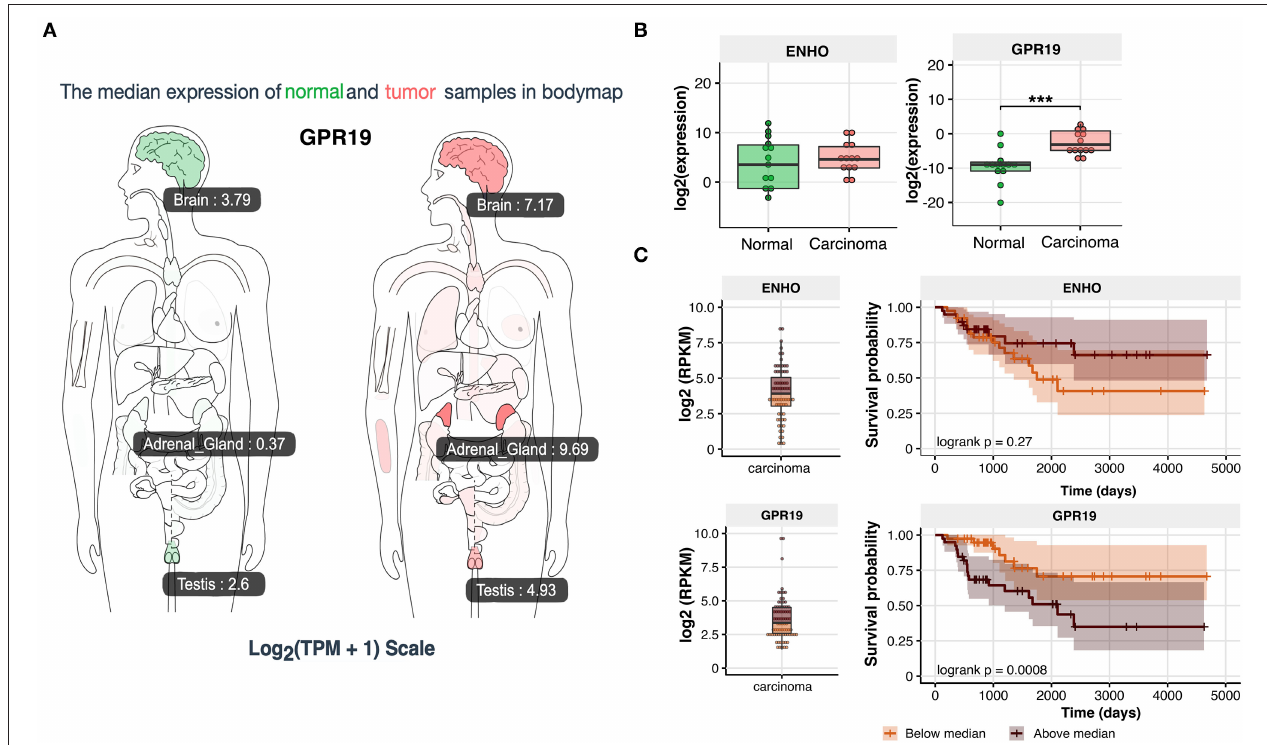
FIGURE 12 | Expression of ENHO and GPR19 in clinical samples. (A) Profile of GPR19 expression in normal and tumor samples from GEPIA (Gene Expression Profiling Interactive Analysis) database. (B) Expression of ENHO and GPR19 in normal and tumor samples of human adrenal gland. (C) Kaplan–Meier survival analysis of 92 cases of adrenocortical carcinoma obtained from TCGA database. Expression data for ENHO and GPR19 were divided into group with high (above median) and low expression (bellow median). Statistical differences were determined by the Mann–Whitney U non-parametric test compared to normal adrenals. *** p <